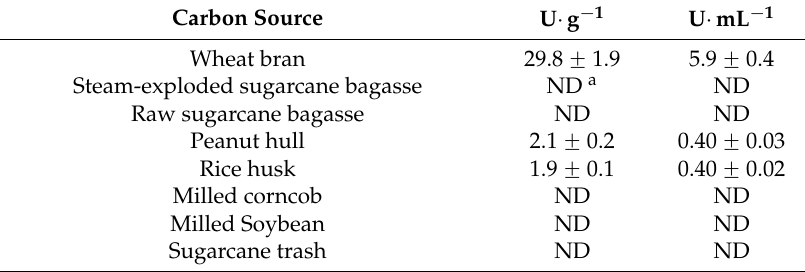
Table 1. Effect of different carbon sources and supplementary carbon and nitrogen sources on the production of laccases by P. sanguineus